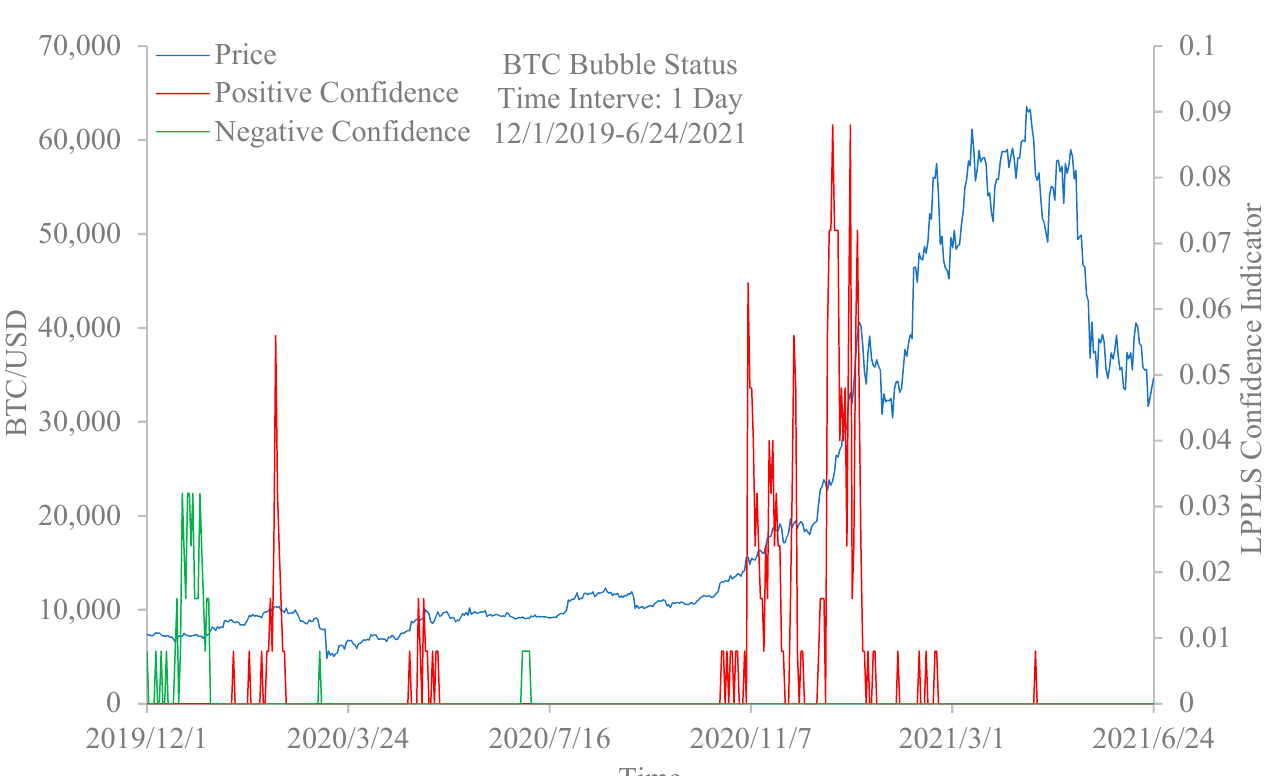
Figure 4. Daily LPPLS confidence indicator for positive bubbles is shown in red and negative bubbles in green (right scale), along with the Bitcoin price in blue (left scale), from 12/1/2019 to 6/24/2021.